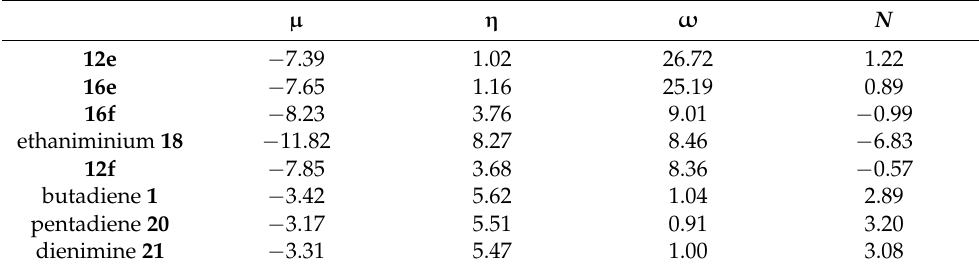
Table 2. B3LYP/6-31G(d) global reactivity indices; the electronic chemical potential, µ ; chemical hardness, η ; electrophilicity, ω ; and nucleophilicity, N ; in eV, of the reagents participating in the I-DA and IIDA reactions herein